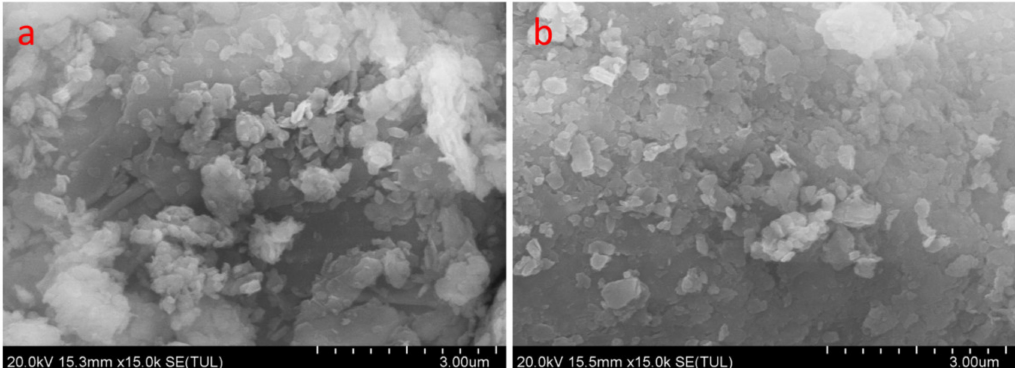
Figure 3. SEM micrographs of starting sample: ( a ) RCG; ( b ) ACG.